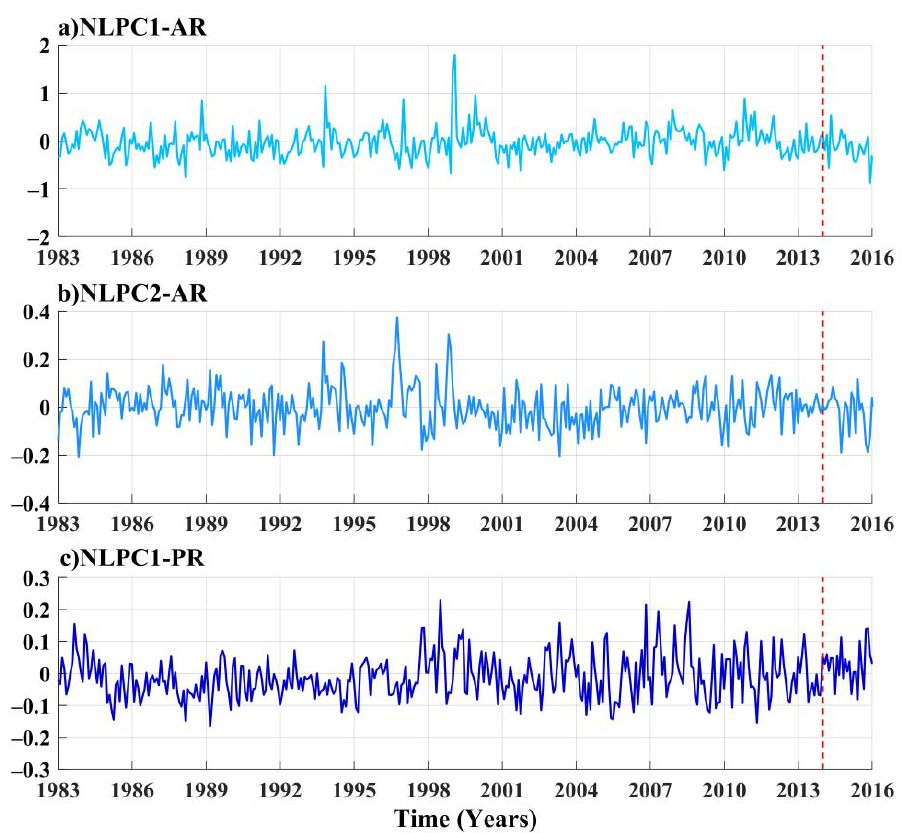
Figure 5. Non-linear principal components (1983–2016) for the Andean Region and the Pacific Region. ( a ) NLPC1-AR, ( b ) NLPC2-AR, and ( c ) NLPC1-PR. The red dotted line indicates the starting point of